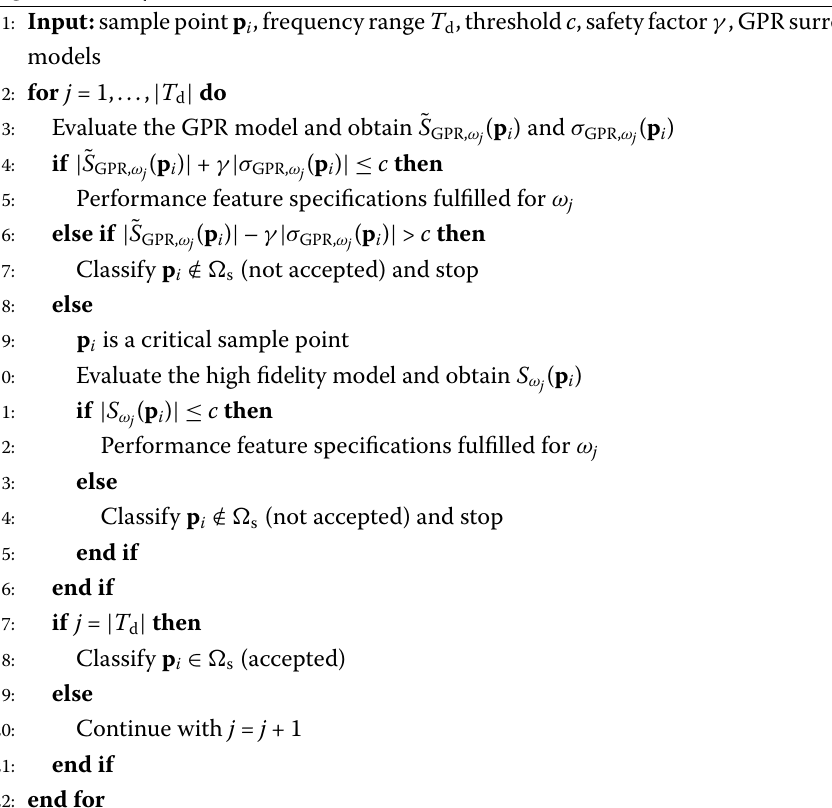
Algorithm 1 Hybrid